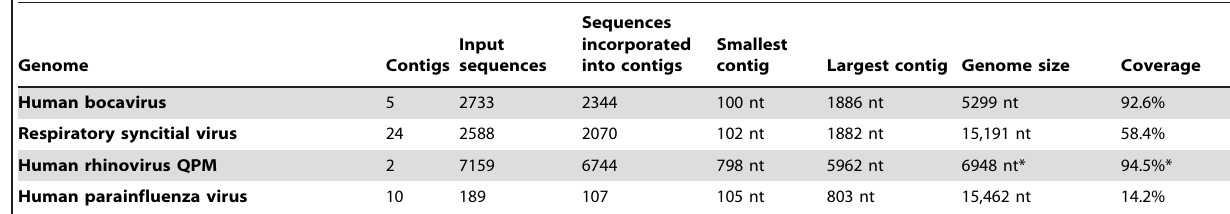
Table 5. Genome coverage.